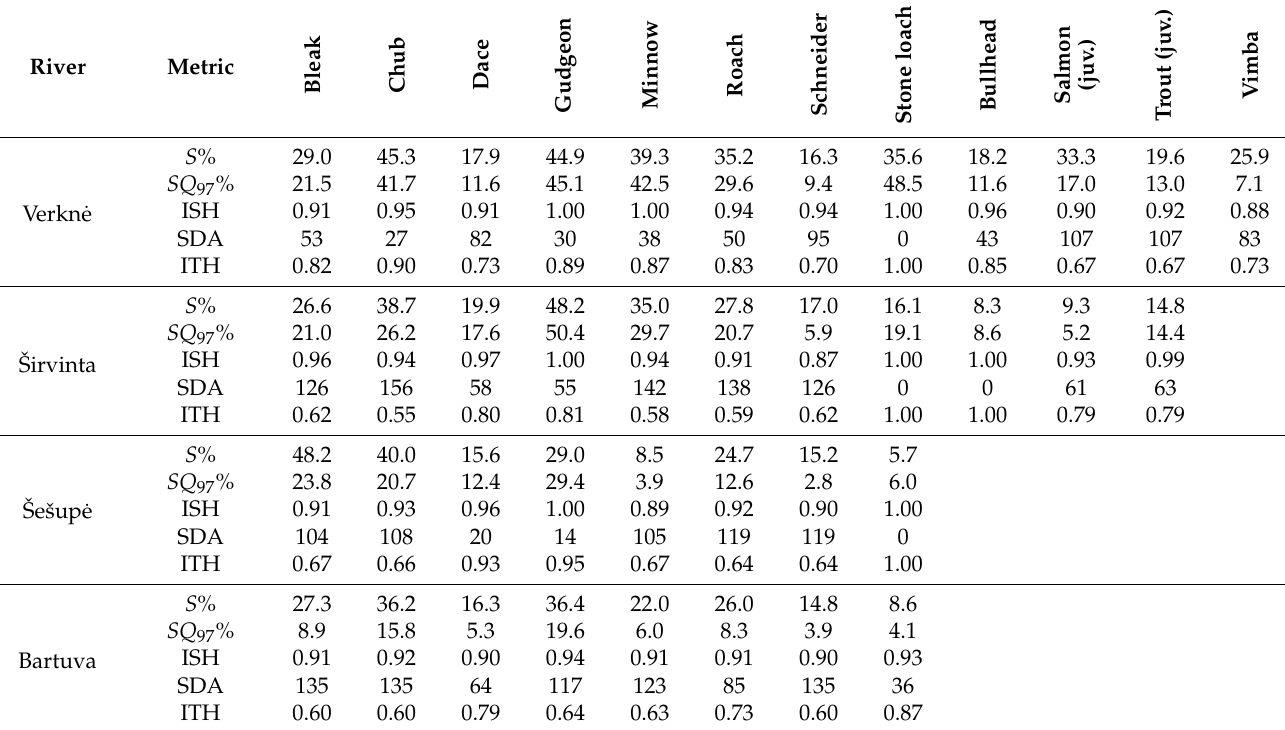
Table 5. The relative mean habitat area (% of river channel; S %) of the modeled fish species, the relative habitat area at a discharge of Q 97 ( SQ 97 %) at natural conditions, and the average amount of habitat loss (index of spatial habitat availability; ISH), and the relative increase (in %) in the cumulative duration of stress days (stress days alteration SDA and corresponding index of temporal habitat availability ITH) when the area of habitat falls below SQ 97 % when HPPs function. Species with a modelled S % < 5 or SQ 97 % < 2.5 are